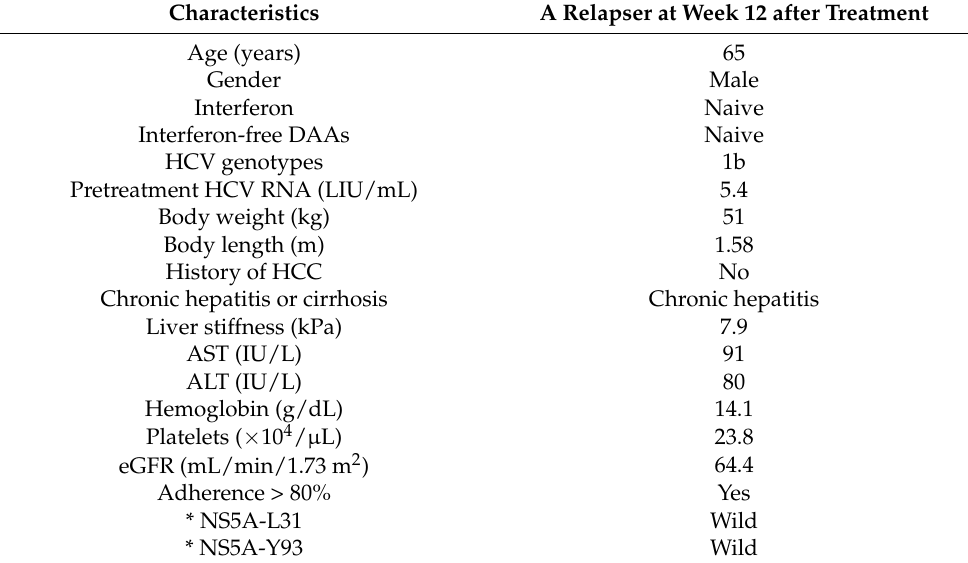
Table 2. Baseline characteristics of a relapser after 8 weeks of glecaprevir/pibrentasvir. Characteristics A Relapser at Week 12 after